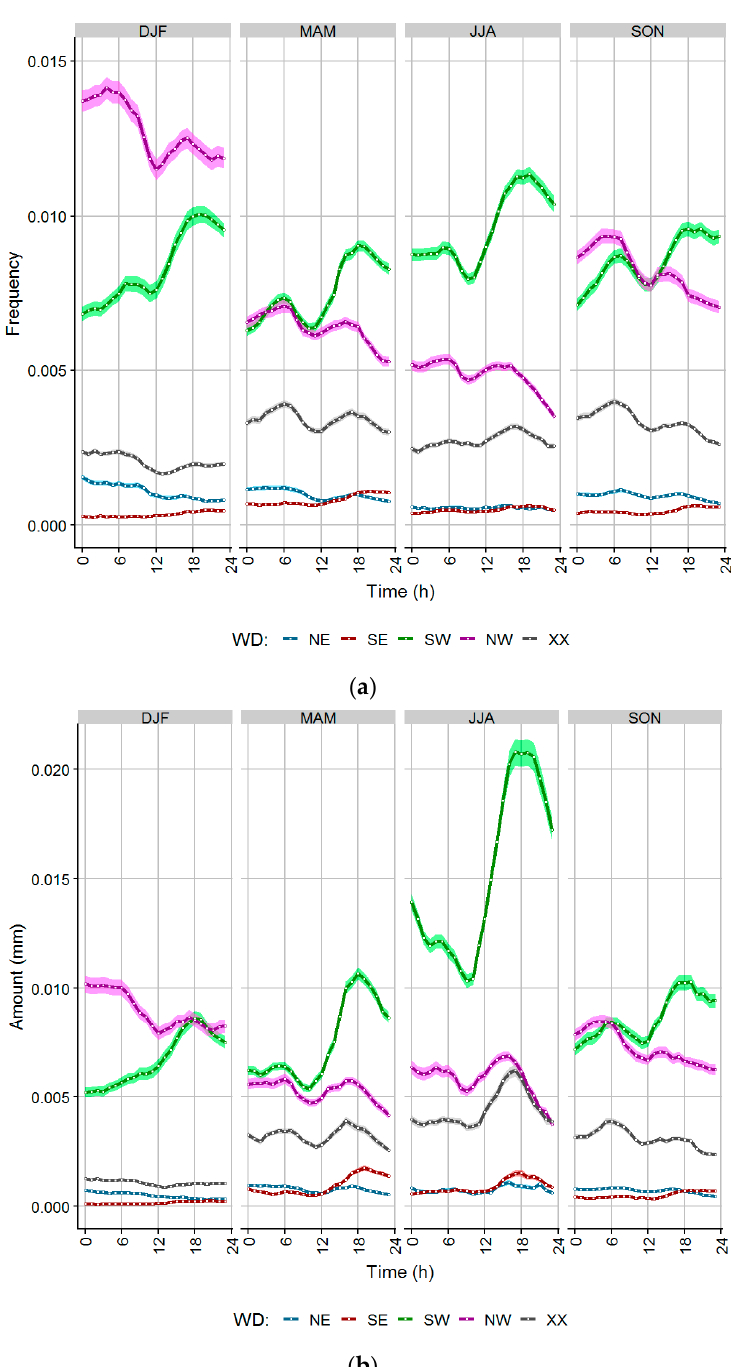
Figure 10. Precipitation diurnal cycle variation in different wind direction (WD) classes and seasons represented by the long-term averages of the hourly precipitation occurrence frequency ( a ) and the hourly precipitation amount ( b ) with the shaded 95% confidence intervals. The colors represent the four WD classes, while the panels represent the four seasons.